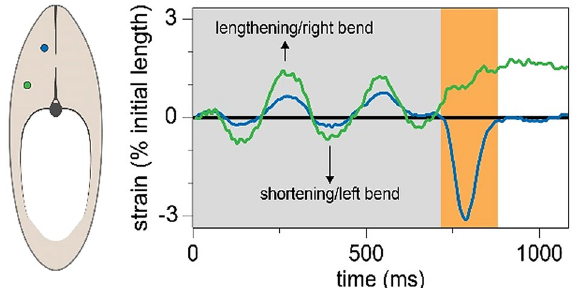
Figure 4. Muscle length dynamics in burst swimming followed by mixed swimming and feeding behavior. Plot shows a sprint (grey area) followed by a strike with body bending to the right (orange area). The sprint sequence shows the expected cycles of muscle lengthening and shortening, and more importantly, the higher magnitudes of longitudinal strain the lateral sonomicrometer (green) relative to the medial sonomicrometer pair. The sprint sequence is then followed by a strike on pellet food with simultaneous lateral flexion to the right, which shows the more complex yet expected pattern of high muscle shortening in the dorsal region (blue) with muscle lengthening in the lateral region (green). Data shown are from individual